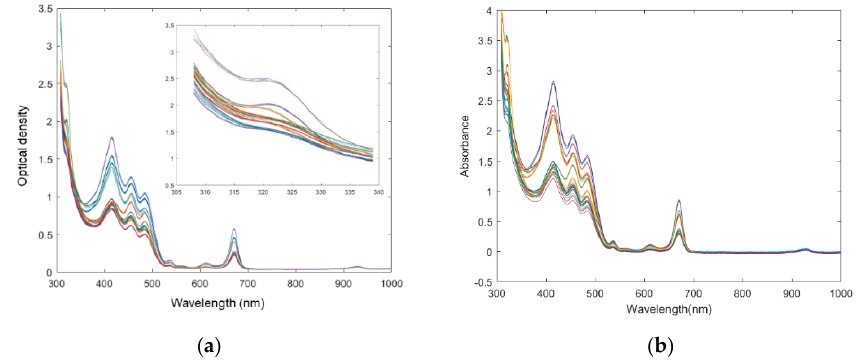
Figure 1. Ultraviolet-visible (UV–Vis) spectra of extra virgin olive oils from different regions obtained by different instruments. ( a ) microtiter plate reader; ( b ) benchtop UV–Vis